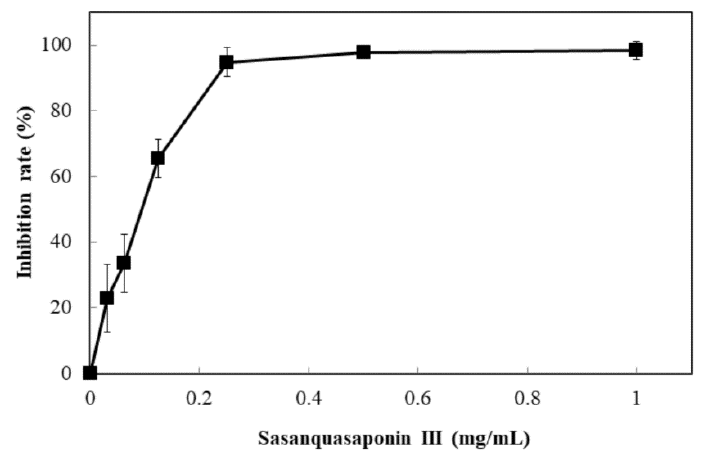
Figure 9. Anticandidal activity analysis of sasanquasaponin III. The liquid culture of C. albicans was introduced into 96-well plate and different concentrations of SSE (0, 0.03125, 0.0625, 0.125, 0.25, 0.5, and 1 mg/mL) was added. The 96-well plate treated with sasanquasaponin III was cultivated at 37 °C for 24 h and determined by a plate reader at 600 nm. Results are mean ± S.D. ( n = 3).